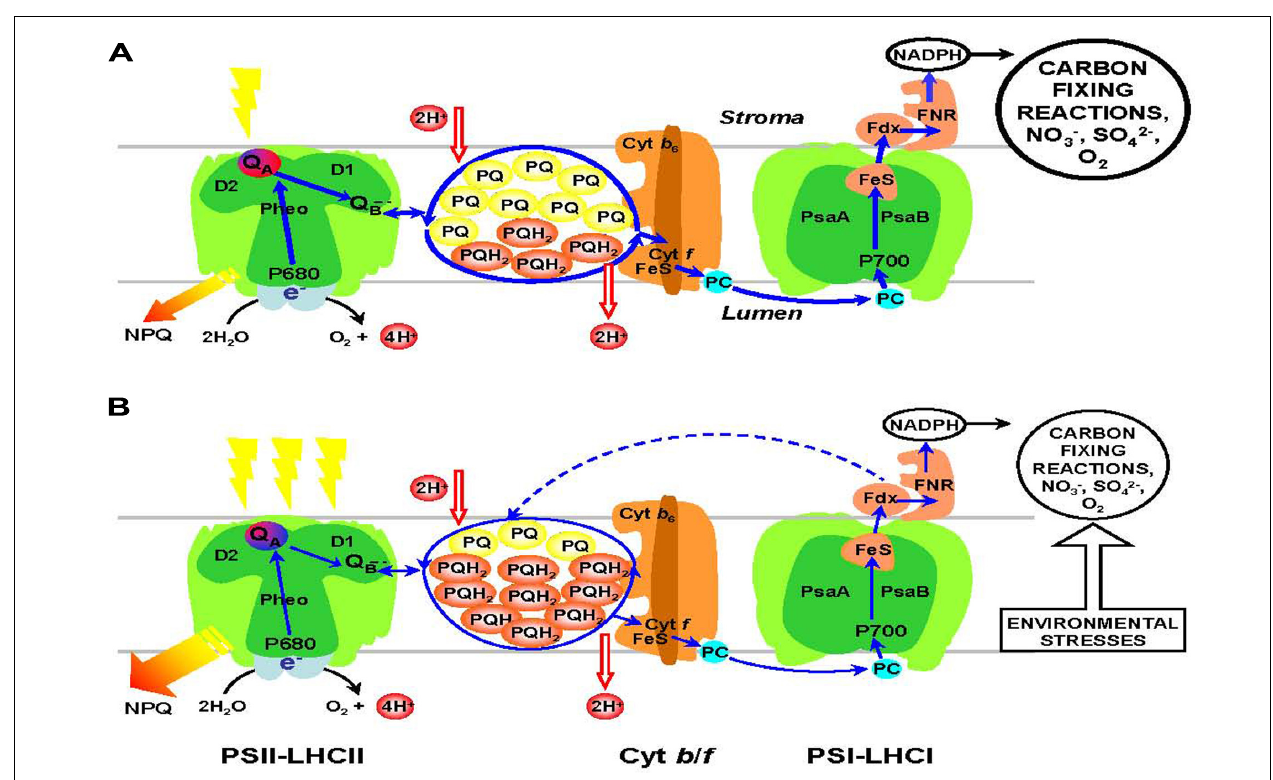
FIGURE 1 | General model of the photosynthetic electron transport chain. (A) Low excitation pressure conditions are indicated by a single yellow lighting bolt. Under these conditions, the PQ pool is largely in the oxidized state because the rate of photosynthetic electron transport plus NPQ match the rate of consumption of photosynthetic reductant, NADPH.Thick solid blue arrows indicate linear electron transport from photosystem II (PSII) to photosystem I (PSI) to reduce NADP + to NADPH which is consumed by C, N, and S metabolism. Energy dissipated as heat through NPQ is minimal. PQ,